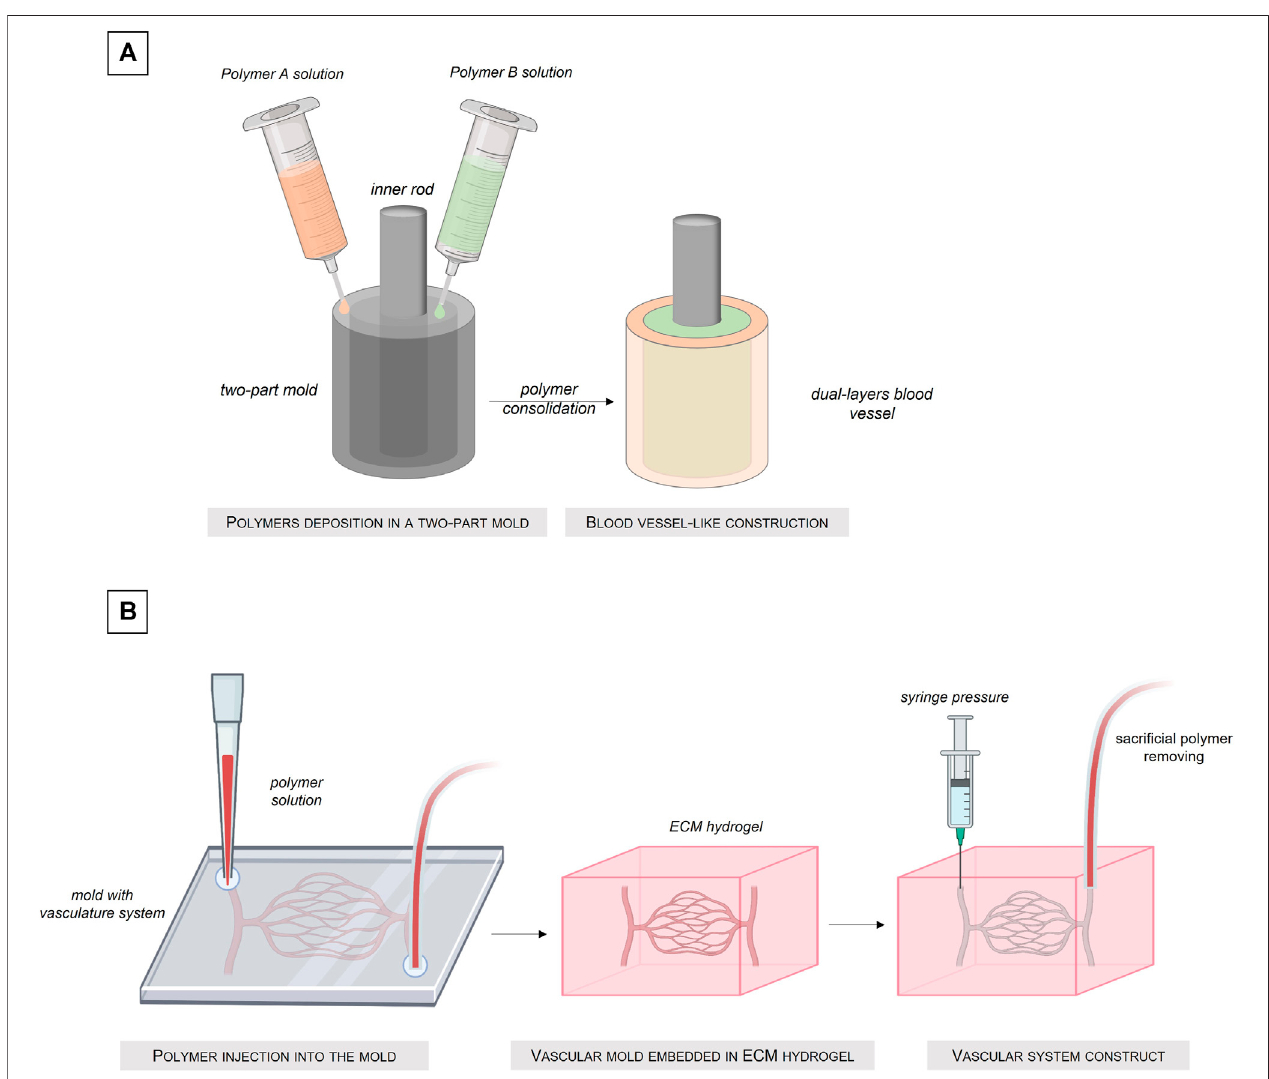
FIGURE5| Fabricationoftissue-engineeredbloodvesselbythemoldingtechnique. (A) Injectionofdifferentpolymersolutionsintoadual-compartmentsmold. (B) Sacri fi cial molding intro an ECM hydrogel.